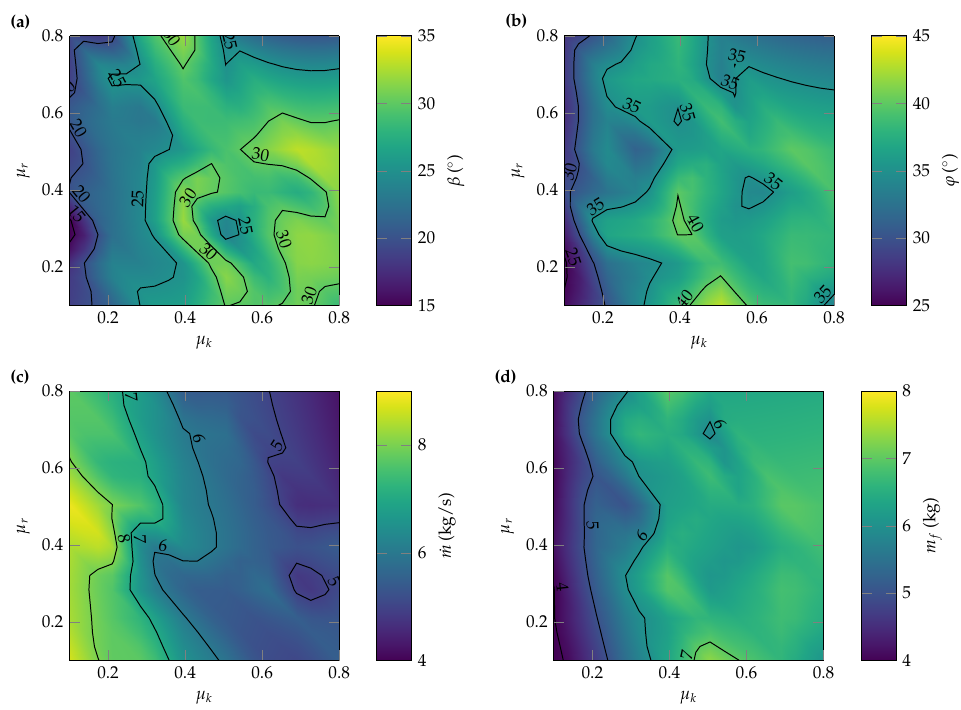
Figure 7. Surface response of friction calibration regarding sliding friction and rolling friction: ( a ) angle of repose, ( b ) shear angle, ( c ) mass flow rate, ( d ) final mass.